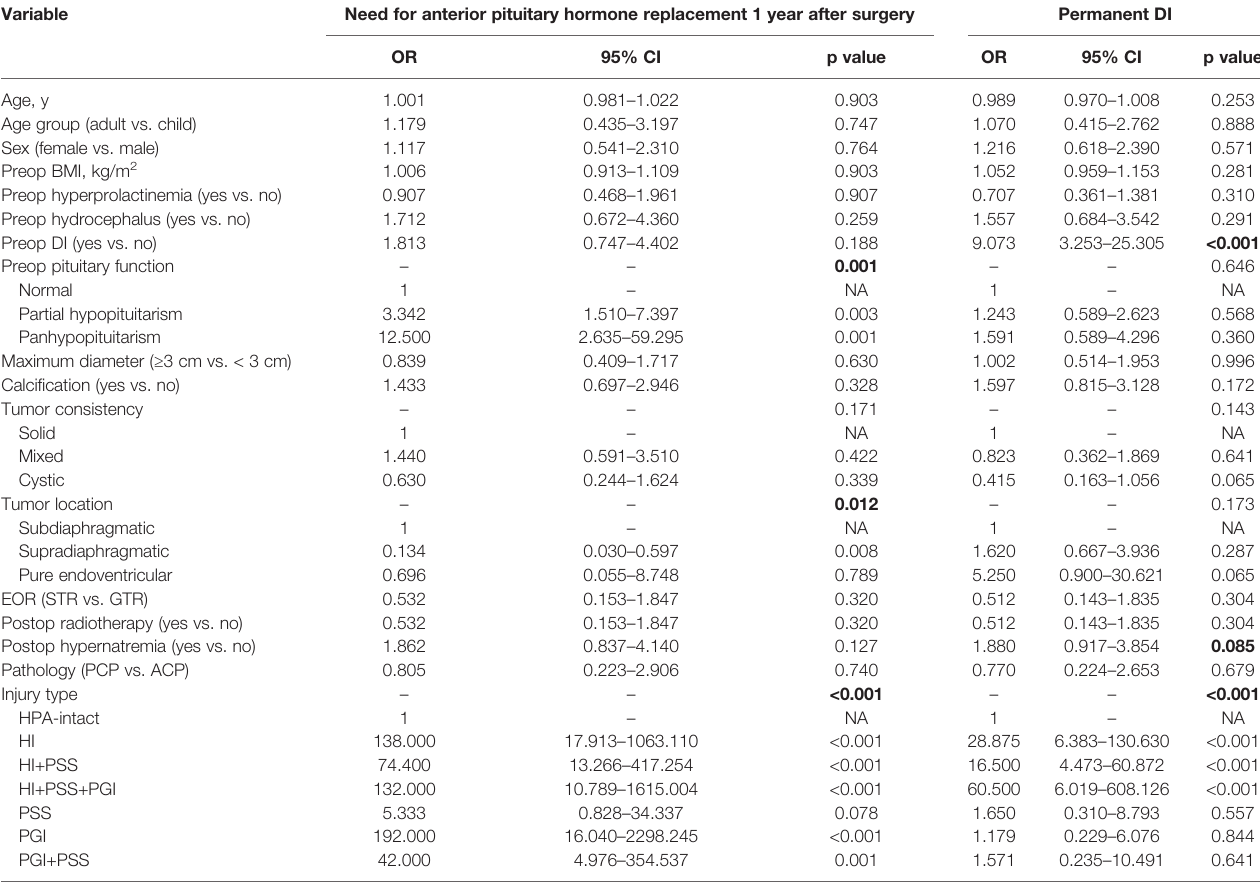
TABLE 2 | Univariate logistic regression analysis of need for anterior pituitary hormone replacement 1 year after surgery and permanent diabetes insipidus (DI) based on pre-, intra-, and postoperative data in the training cohort. Variable Need for anterior pituitary hormone replacement 1 year after surgery Permanent